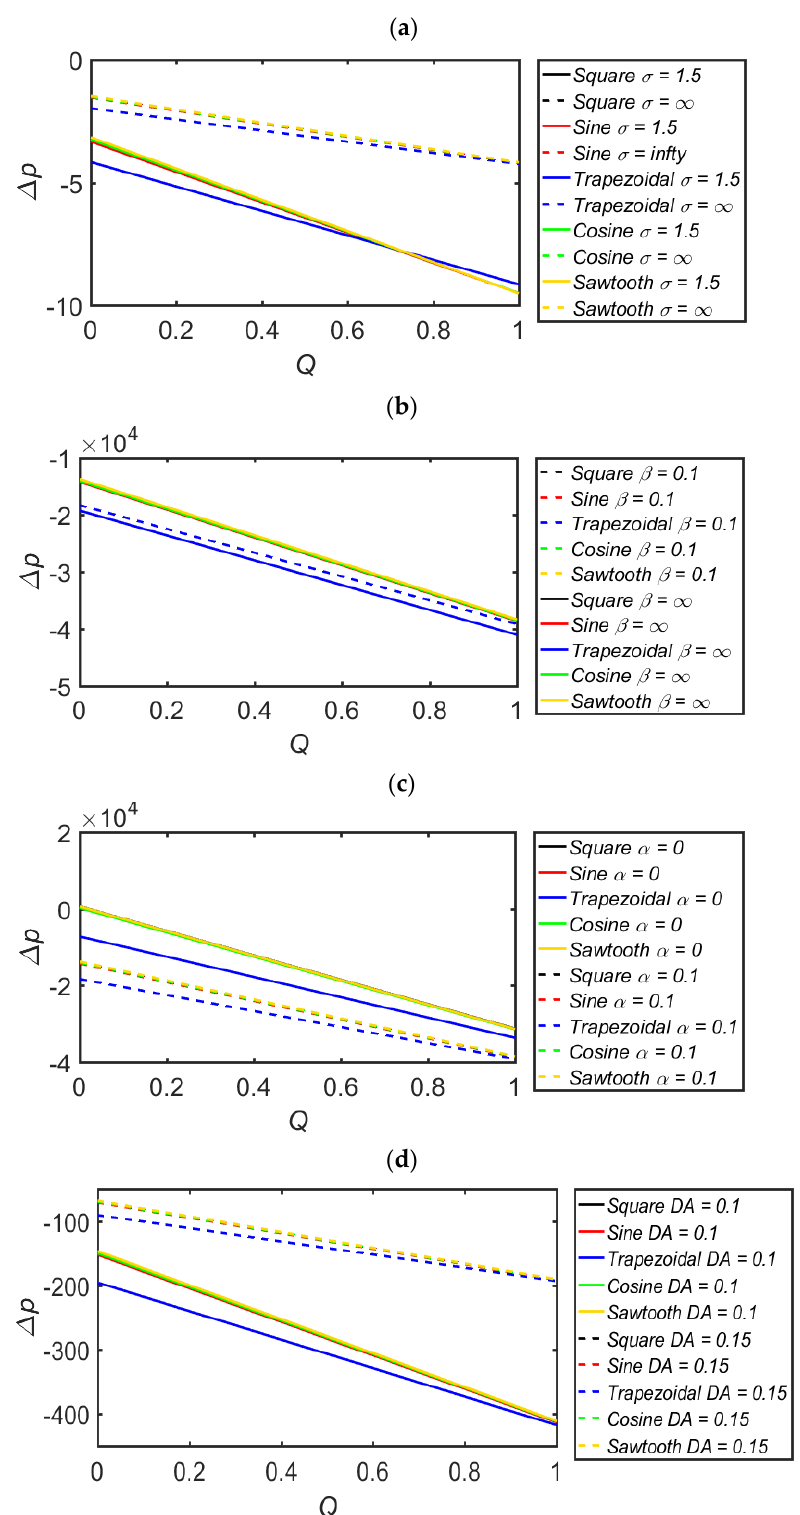
Figure 4. ( a ) The pressure gradient 𝑑𝑝/𝑑𝜂 for curvature parameter (𝜎) at 𝑞 = −1.5,𝐷𝐴 = 0.01,𝛼 = 0.1,𝛽 = 0.5,and 𝜙 = 0.2. ( b ) The pressure gradient 𝑑𝑝/𝑑𝜂 for viscoelastic parameter (𝛽) at 𝑞 = −1.5,𝐷𝐴 = 0.01,𝛼 = 0.1,𝜎 = 3 & 𝜙 = 0.2. ( c ) The pressure gradient 𝑑𝑝/𝑑𝜂 for non-uniform parameter (𝛼) at 𝑞 = −1.5,𝐷𝐴 = 0.01,𝜎 = 3,𝛽 = 0.5,and 𝜙 = 0.2. ( d ) The pressure gradient 𝑑𝑝/ 𝑑𝜂 for porosity parameter (𝐷𝐴) at 𝑞 = −1.5,𝛽 = 0.5,𝛼 = 0.1,𝜎 = 3,and 𝜙 = 0.2.